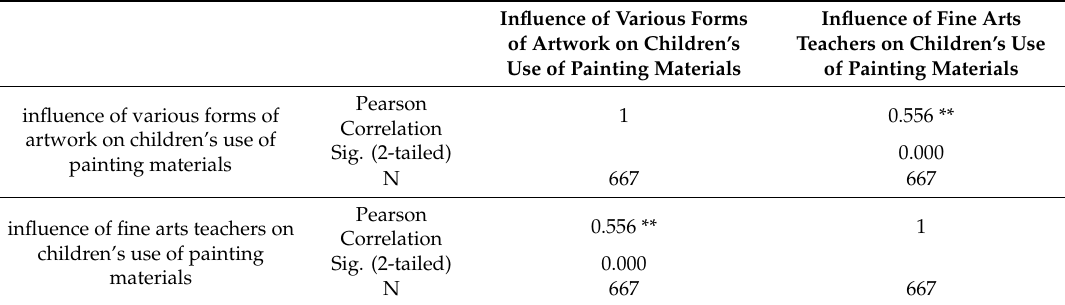
Table 6. The correlations analysis between the influence of various forms of artwork on children’s use of painting materials and the influence of fine-arts teachers on children’s use of painting